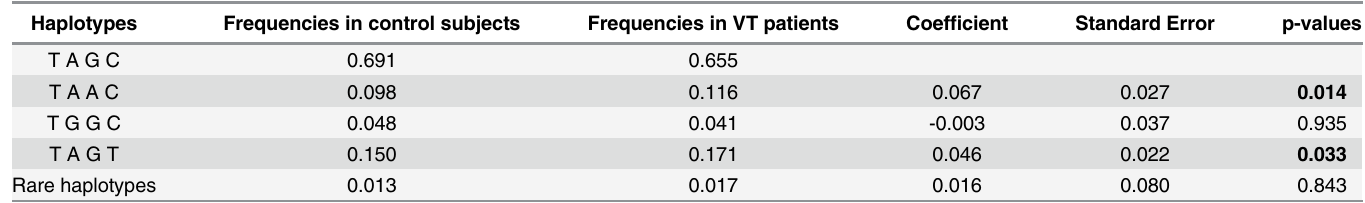
Table 4. Haplotypes reconstruction analysis of the four SNPs in the LPA gene and analysis of association with VTE by using the generalized linear model (adjusted for venous thrombosis risk factors * ).